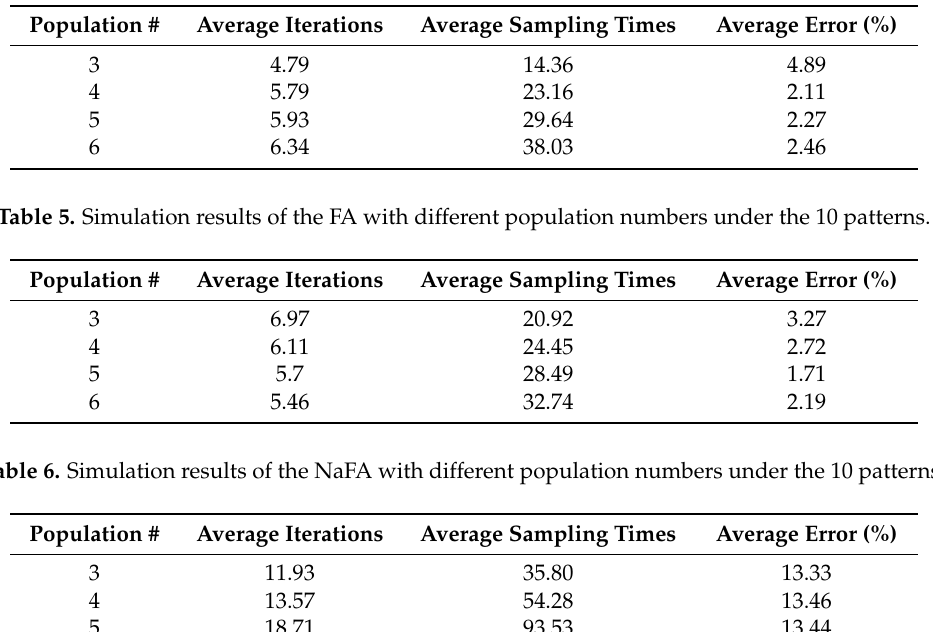
Table 4. Simulation results of the FPA with different population numbers under the 10 patterns.